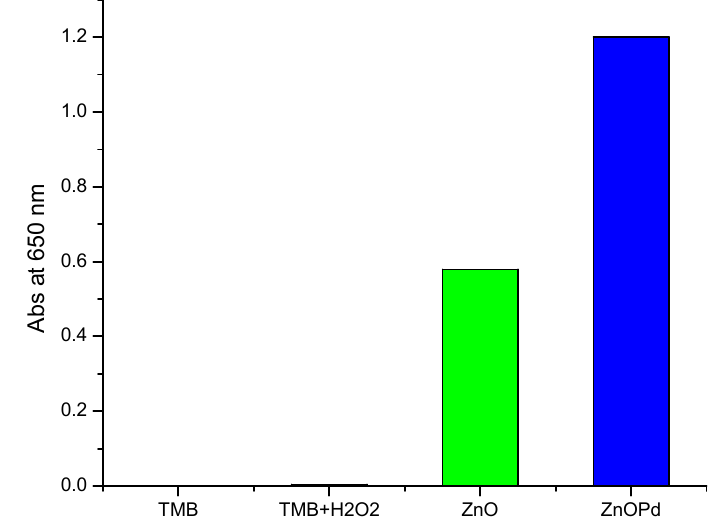
Figure 5. Catalytic comparison of 3,3 ′ ,5,5 ′ -tetramethylbenzidine (TMB) oxidized by ZnO and ZnO-Pd nanosheets by measuring the absorbance at 650